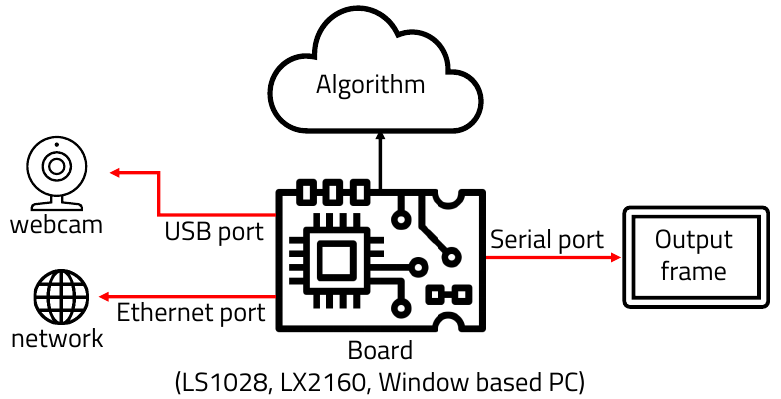
Figure 12. Structure of boards and